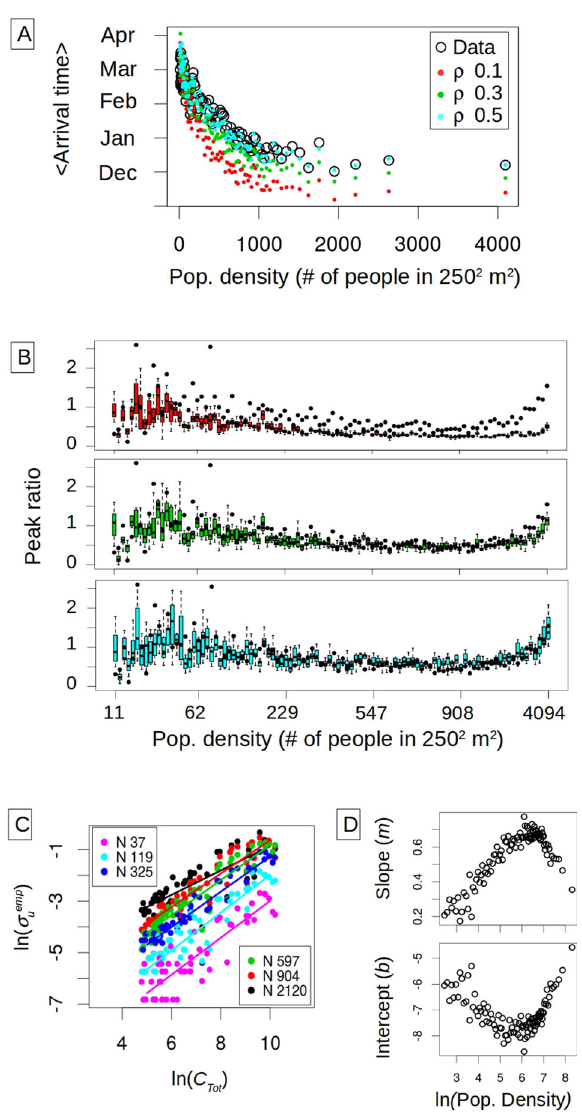
Fig. 4 Stochastic simulations and empirical “ spark ” rate (number of sparks per month per unit). A Mean observed arrival time as a function of human density. The original units are binned into 100 groups and arrival times are averaged for the units belonging to the same group. The arrival times computed from the data (black circles) are compared to those obtained in model simulations (with dots colored by reporting rate). B Peak ratio obtained in the simulations as a function of population density for the different reporting rates where the colors correspond to those in ( A ). The boxplots are computed from 20 stochastic realizations (in these, the box illustrates, as is standard, the median with the 25th and 75th percentiles, and the dotted lines indicate the extremes of the distribution). For comparison, the empirical values of peak ratio are also shown (in black, for the 100 groups). C Spark rate as a function of total incidence ( C Tot ). The logarithm of the number of sparks (or number of imported infections) per month per unit exhibits a linear relationship with the logarithm of the total number of cases in the city. The more populated units receive a higher number of sparks as expected in a pattern that is well approximated by a power law. D The parameters of the power relationship between spark rate and total incidence vary as a function of population density. The different slopes ( m ) and intercept ( b ) from a linear regression to the log – log plot are shown in ( C ) as a function of the logarithm of population density. Thus, importation rate to a unit exhibits both a global and a local determinant, namely the total number of cases in the city and the local population in a given unit. These dependencies allow the speci fi cation of infection importation via a mean- fi eld coupling and local conditions, circumventing the need to explicitly describe spatial connectivity at fi ne